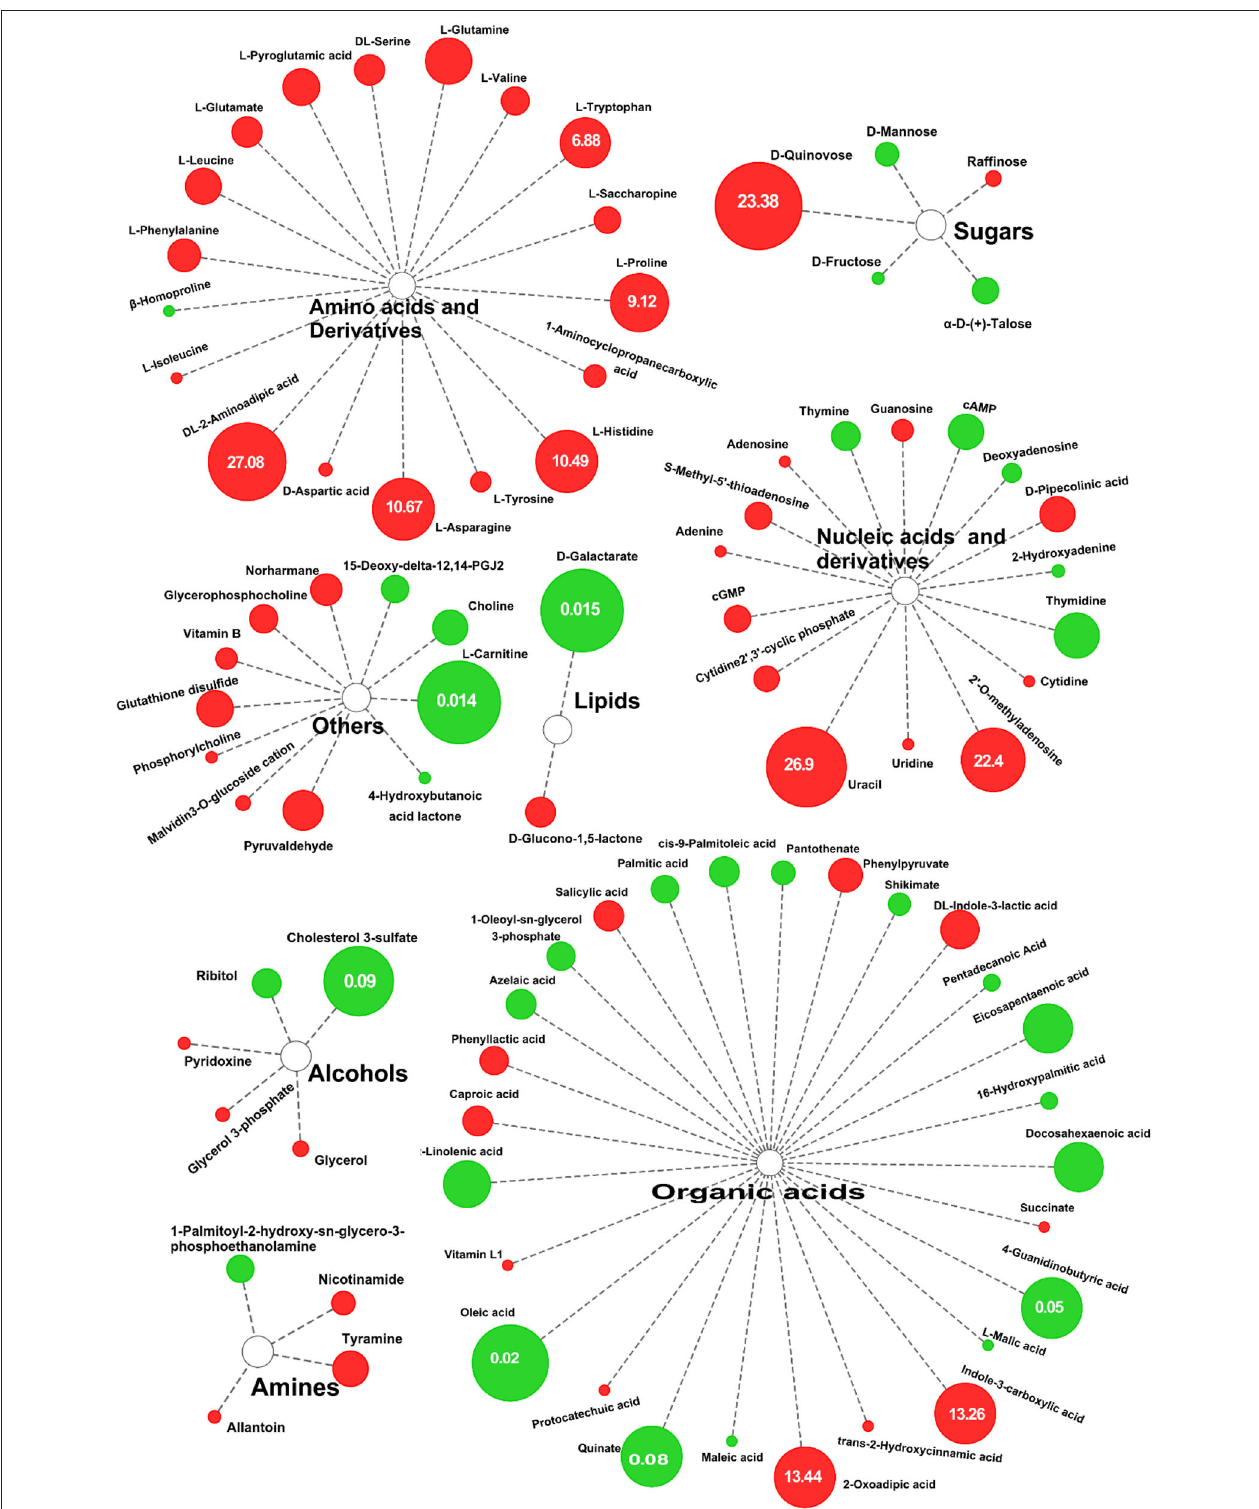
FIGURE 4 | Differential metabolites of DN and DS. The sizes of the circles reflect FC in abundance between DN and DS; red indicates significantly upregulated in DS, green indicates significantly downregulated. DN is DXWR without salt treatment and DS is DXWR under salinity.